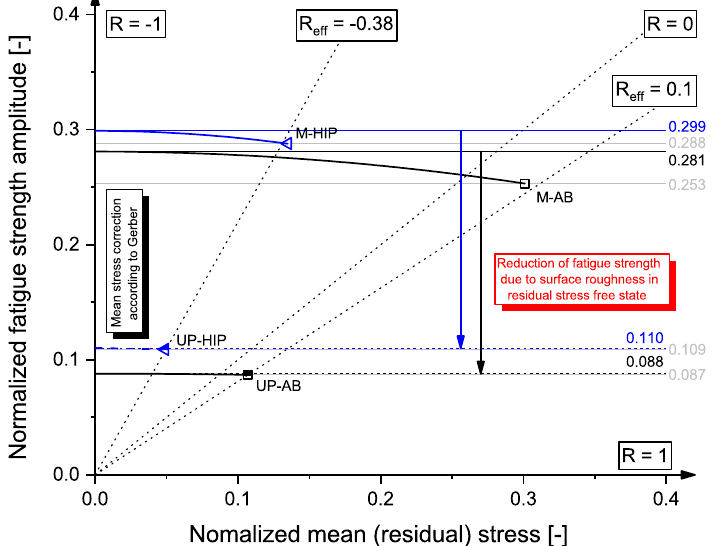
Figure 13. Haigh diagram with residual stresses accounted for according to